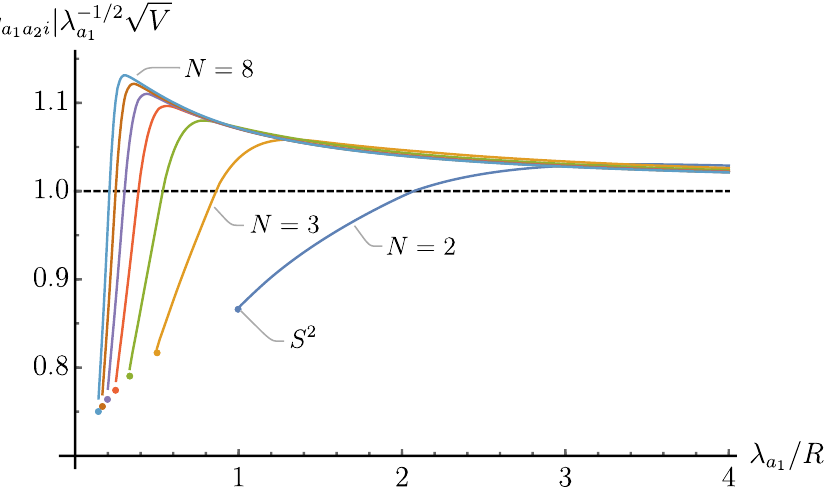
p j (cid:21) (cid:0) 1 = 2 a V for closed Einstein manifolds with R > 0 1 1 a 2 i